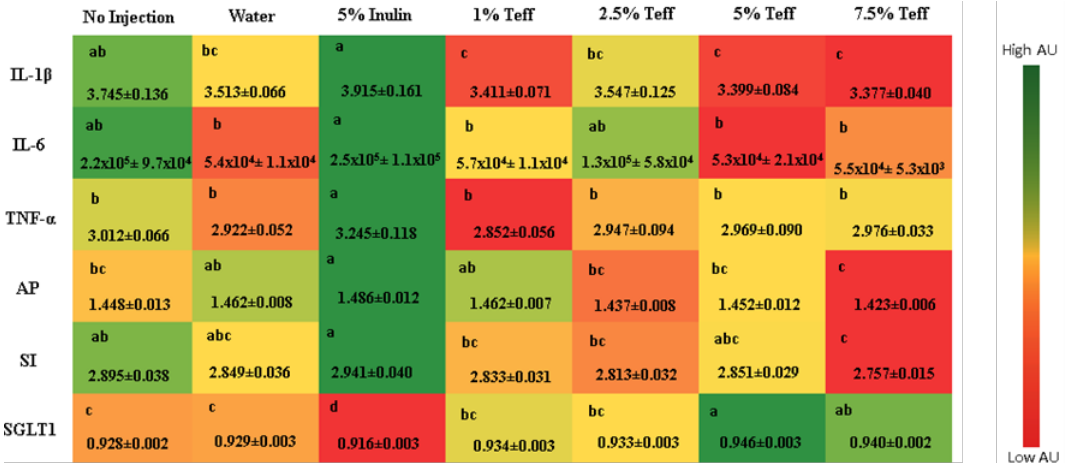
Figure 3. E ff ect of the intra-amniotic administration of experimental solutions on intestinal and heart gene expression. Values are the means (AU: arbitrary units) ± SEM, n = 8. a – c Per gene, treatments groups not indicated by the same letter are significantly di ff erent ( p < 0.05). IL-1 β , Interleukin 1 beta; IL-6, Interleukin 6; TNF- α , Tumor Necrosis Factor Alpha; AP, Amino peptidase; SGLT1, Sodium-Glucose transport protein 1; SI, Sucrose isomaltase.